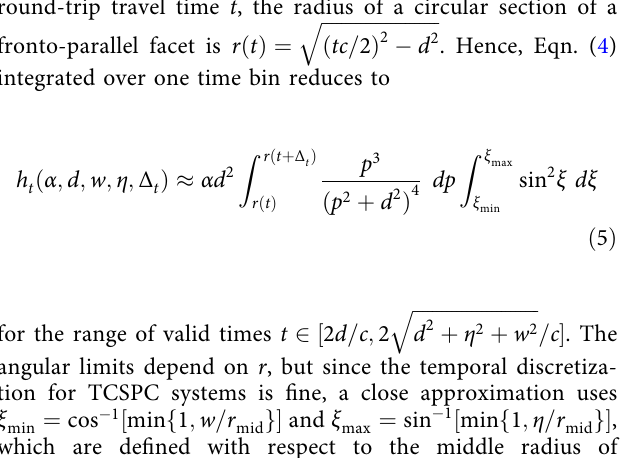
Fig. 2 Planar facet scene representation. a The contents of a wedge spanning angle Δ θ are represented by a set of planar facets parameterized by a distance ρ , height η , albedo α , and orientation angle ϕ . b The basic transient light transport is computed for the region illuminated between times t and t + Δ t of one-half of a fronto-parallel facet. For facets with nonzero ϕ , the full response linearly combines two half-facet responses with the distance and widths adjusted according to orientation angle. c The response from a ceiling component is computed similarly to a fronto-parallel facet. d Only the portion of a facet not occluded by a closer facet contributes to the total response. The effects of varying the facet parameters on the facet transient response are visualized in Supplementary Movie